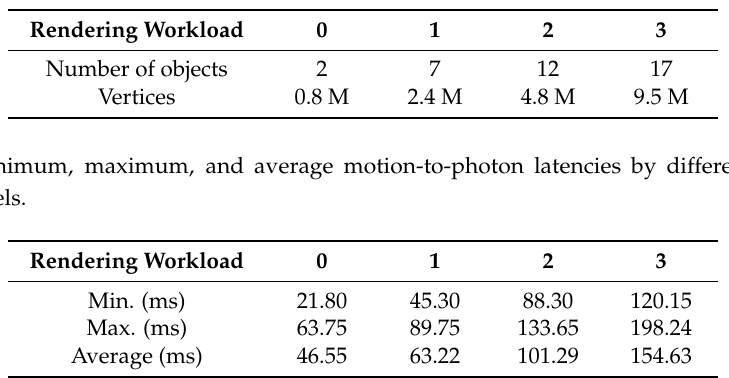
Table 3. Various rendering workloads and vertices.